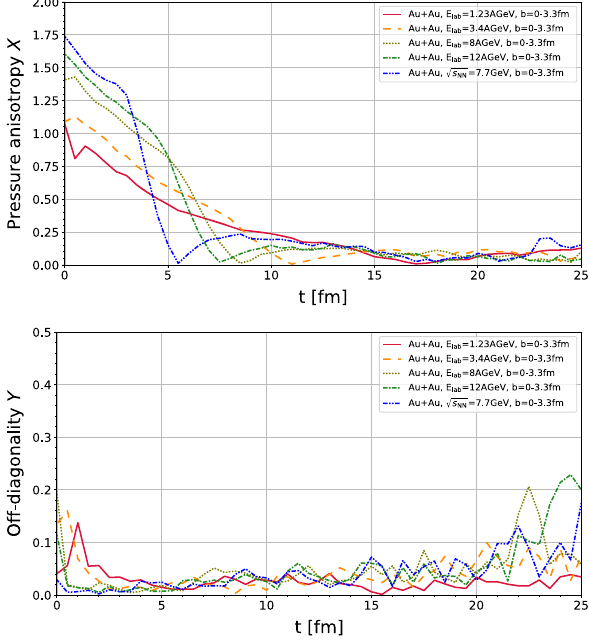
Fig. 4 Time evolution of the pressure anisotropy X (upper plot) and off-diagonality Y (lower plot) in the center of the system. The plots refer to Au+Au collisions, 0–5% centrality class, at E lab = 1.23, 3.4, 8, √ s NN = 7.7 12 AGeV and